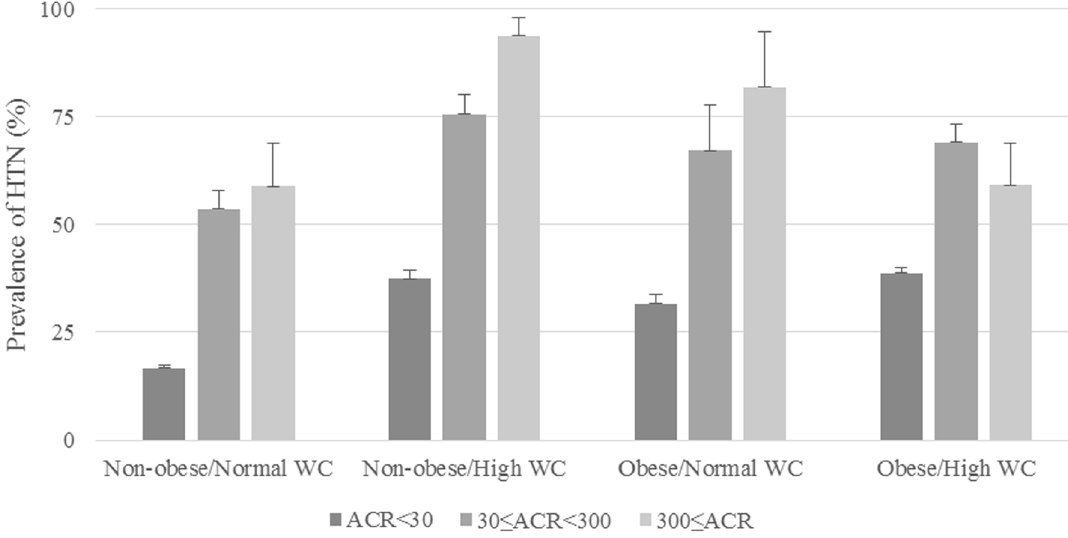
Figure 1. Prevalence of HTN in subjects with and without obesity and abdominal obesity by tertile of ACR. All p values for trends were , 0.001. All p values were , 0.001 between two groups; ACR , 30 vs. 30 # ACR , 300, and ACR , 30 vs. ACR $ 300 at all groups. HTN, hypertension; ACR, albumin–creatinine ratio; WC, waist circumference.